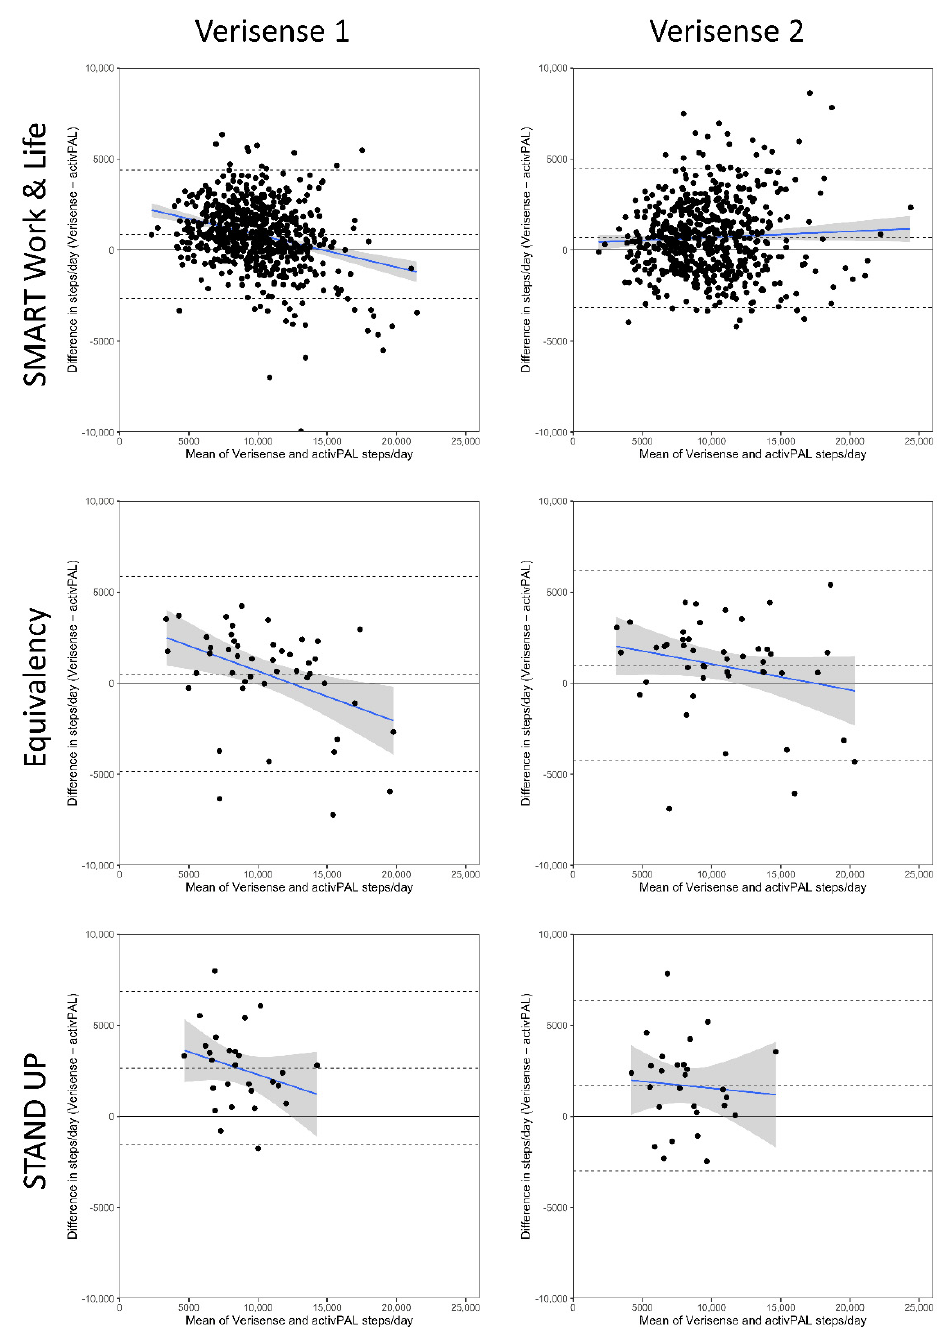
Figure 2. Bland–Altman Plots of total steps/day derived from the Verisense algorithm compared with the activPAL split by study and algorithm version. The blue line depicts mean (95% CI) proportional bias. Dashed black lines depict ± 95% limits of agreement and mean bias. LoA, Limits of Agreement. Table 3. Agreement between steps derived by the activPAL and steps derived by the Verisense algorithms applied to wrist accelerometer data.